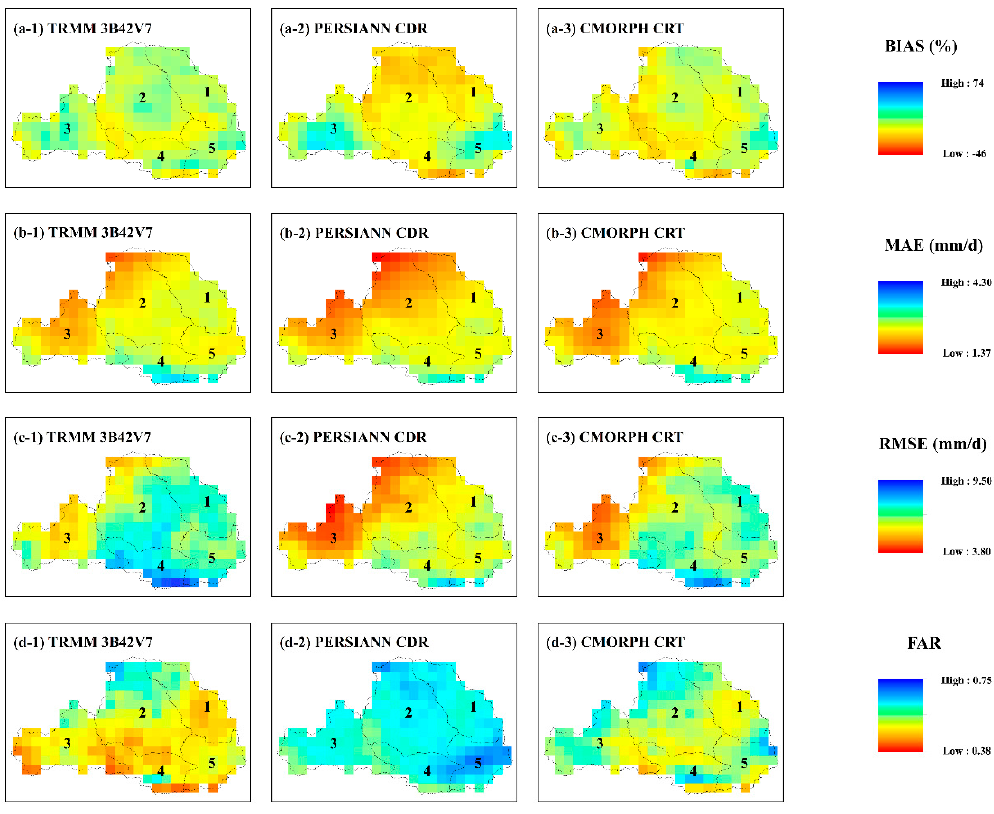
Figure A1. The spatial distribution of the four evaluation metrics for the three post real-time products at the daily and grid scale.